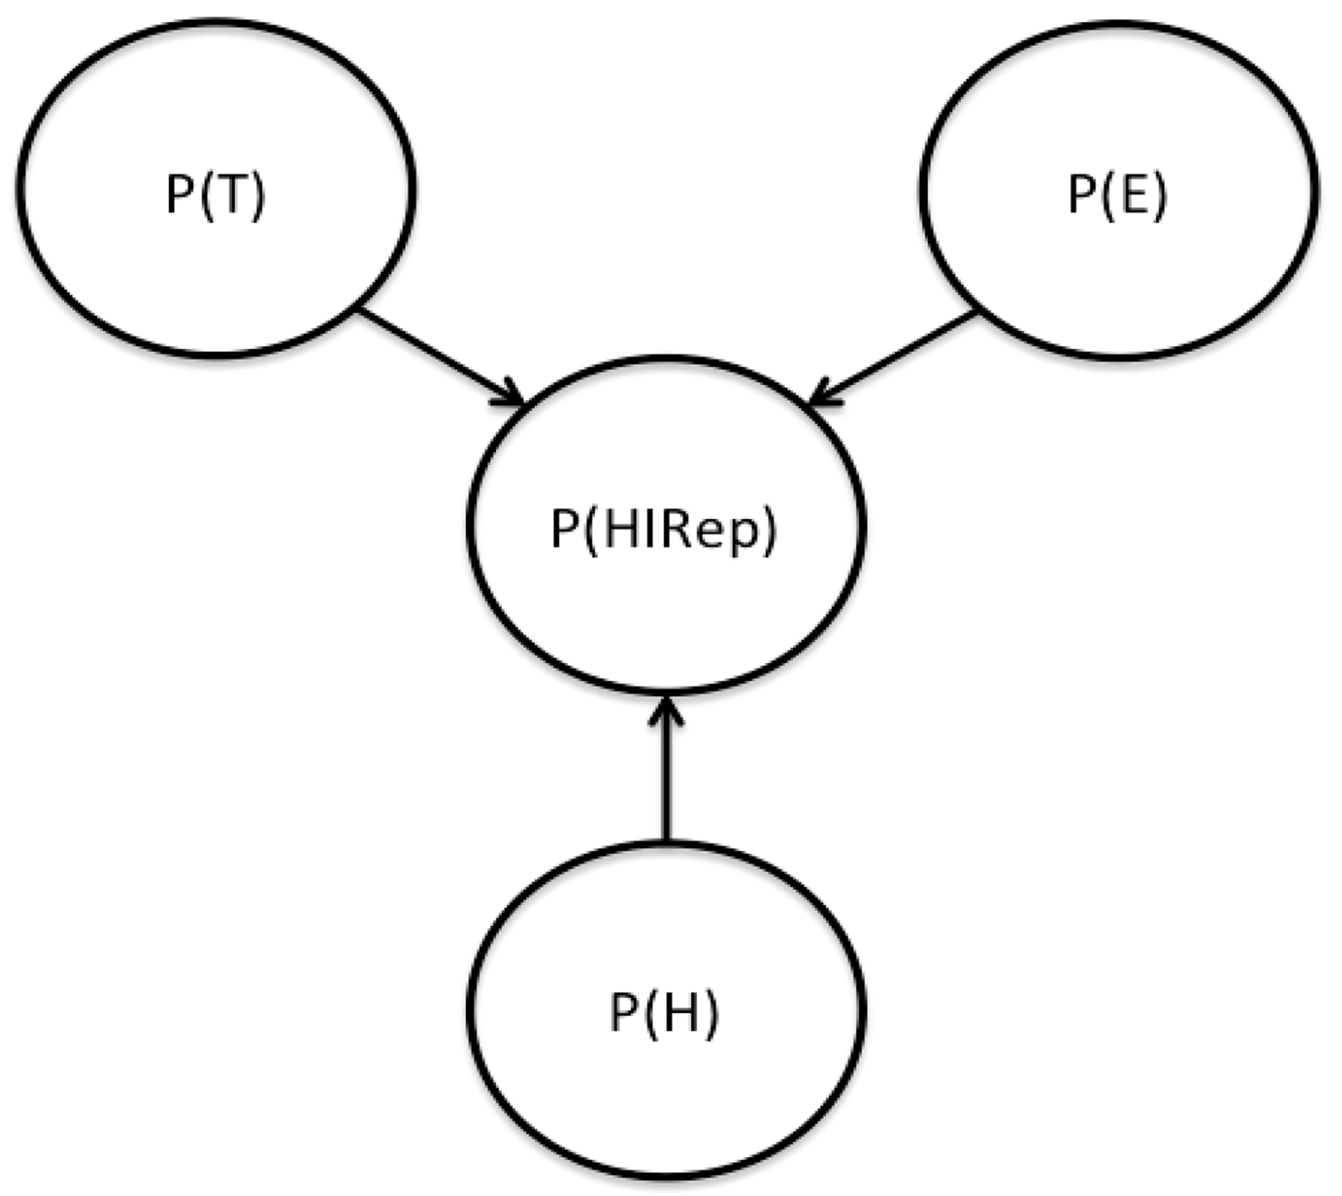
Fig 1. A Bayesian source credibility